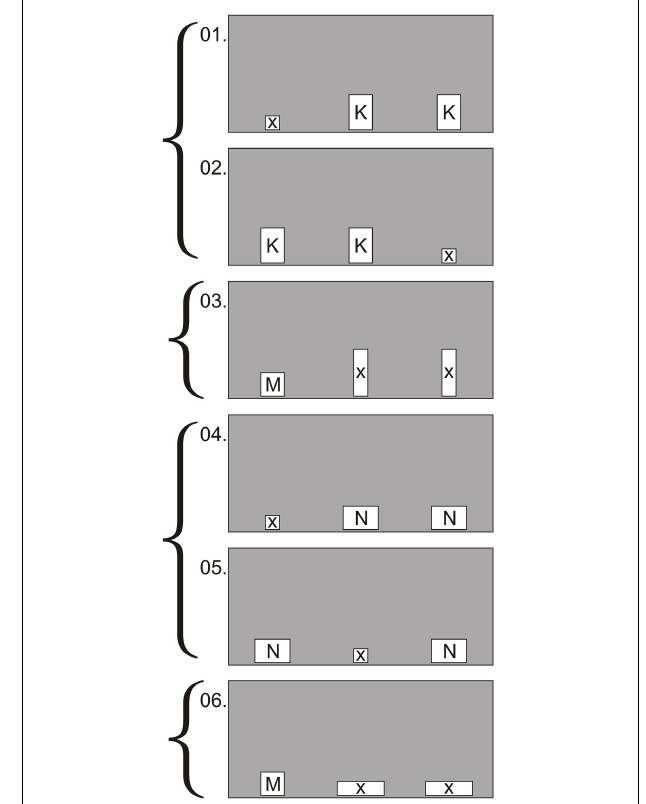
FIGURE 5 | Experiment 2, test: example of the first 6 trials out of 36. 1, 2, 4, and 5 are background trials; 3 and 6—test trials. Holes K, M, and N suit for passage: K—10 × 15 cm; M—10 × 10 cm; N—15 × 10 cm. Holes X unsuitable for passage—6 × 6 cm, 6 × 20 cm, 20 × 6